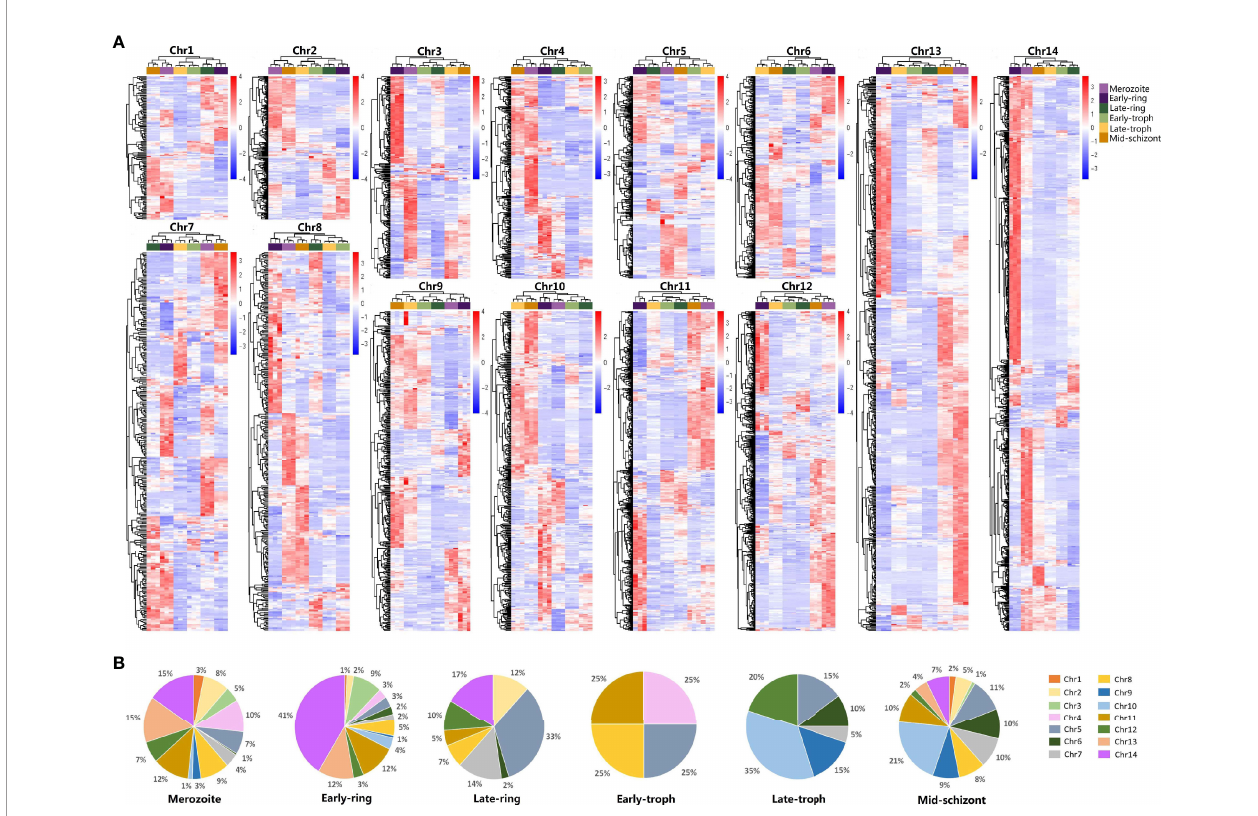
FIGURE 1 | qRT-PCR analysis on the transcriptome pro fi les of Plasmodium falciparum during erythrocytic development. Different developmental stages of P. falciparum 3D7, including merozoite, early-ring, late-ring, early-trophozoite (early-troph), late-trophozoite (late-troph), and middle-schizont (mid-schizont), were collected. Transcription of genes in chromosomes 1 – 14 was detected by qRT-PCR. (A) Heatmaps of the transcriptome of each chromosome (chr). (B) Distribution of highly expressed genes (standard expression value >1, p < 0.05) at different developmental stages on